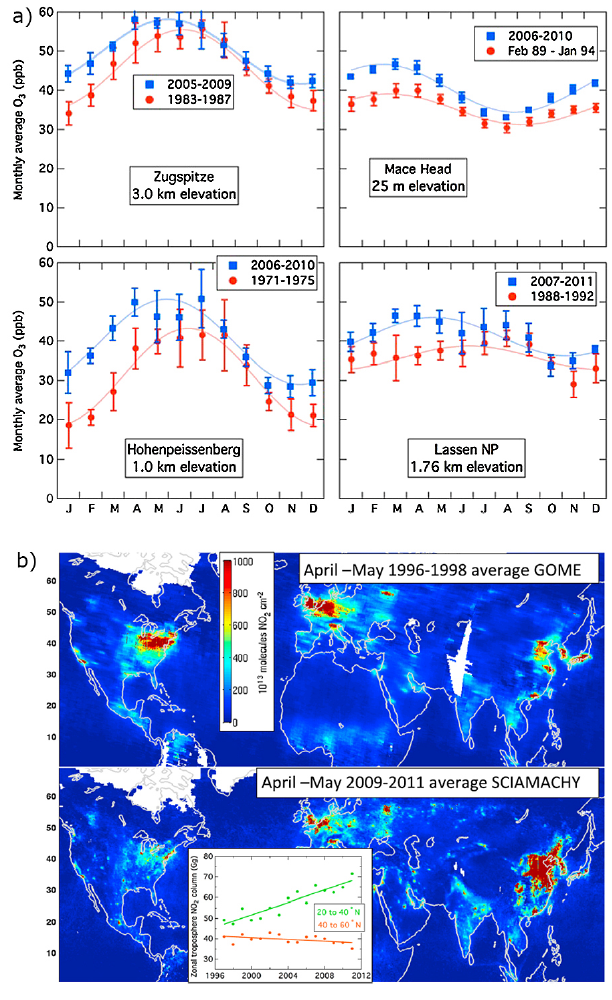
Figure 7. (a) Comparison of O 3 seasonal cycles at three European and one North American sites for two periods separated by 17 to 35 years. The data points and error bars indicate 5-year averages and standard deviations of monthly averaged data for the indicated time periods. The curves of the respective colours are sine function fits to the data. (b) Comparison of satellite-measured springtime tropospheric NO 2 columns during two time periods separated by 13 years. The inset shows the temporal change in the total zonal tro- posphere NO 2 column for two Northern Hemisphere latitude bands (Parrish et al.,